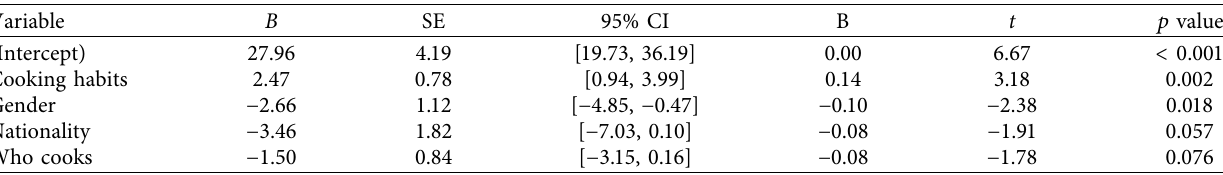
Table 7: Results for linear regression with cooking habits, gender, nationality, and “who cooks” predicting percentage of correct FSK. Variable B SE 95% CI Β